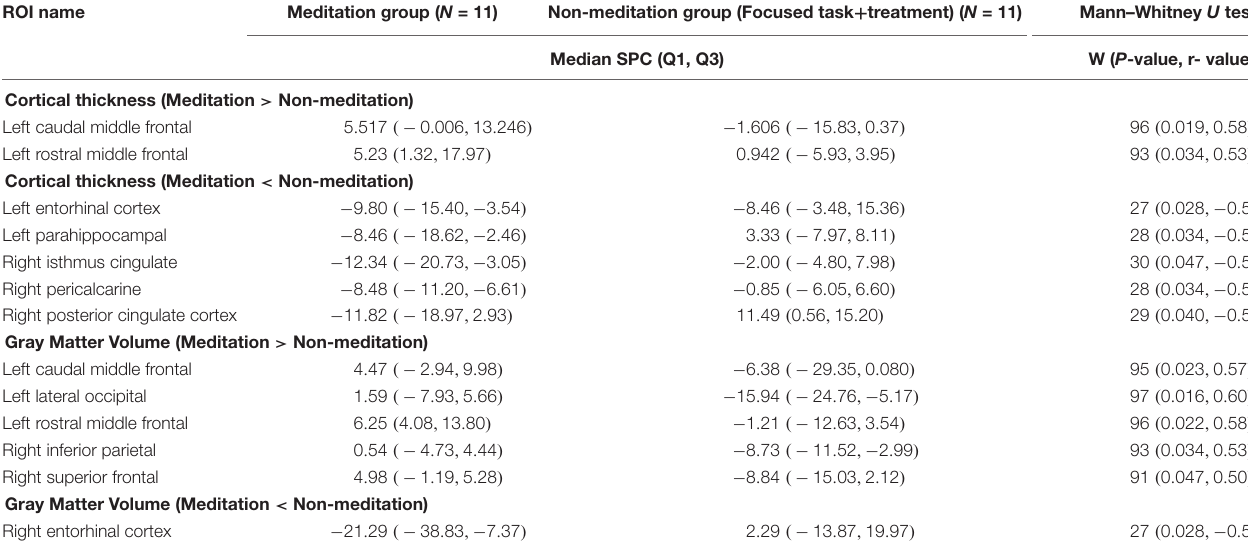
TABLE 4 | Cortical thickness and gray matter volume changes in ROI-based analysis between the meditation and non-meditation groups in both